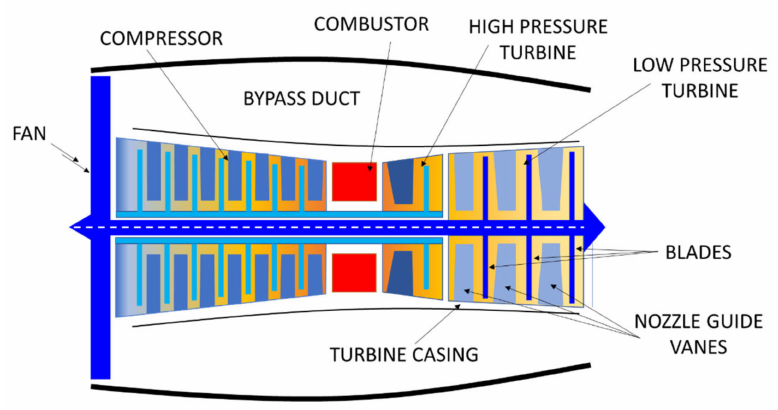
Figure 1. Diagram of two spool turbofan engine [7].